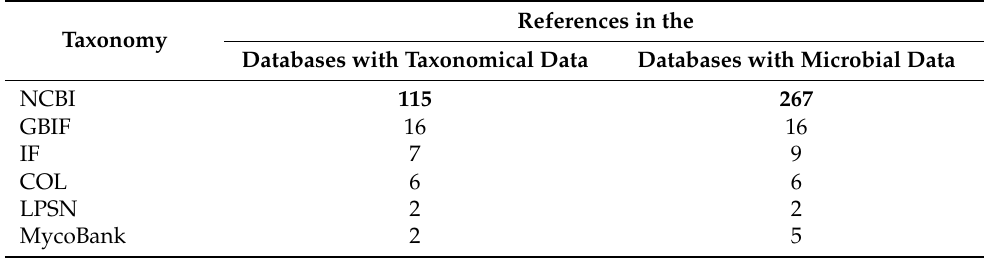
Table 5. Taxonomy in Life Science